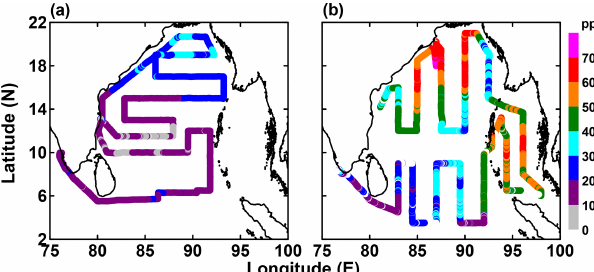
Figure 13. Surface ozone mixing ratios in the Bay of Bengal observed during (a) boreal spring (March–April 2006, ICARB) and (b) winter monsoon (December–January 2009, ICARB). From David et al. (2011), © 2011; reproduced with